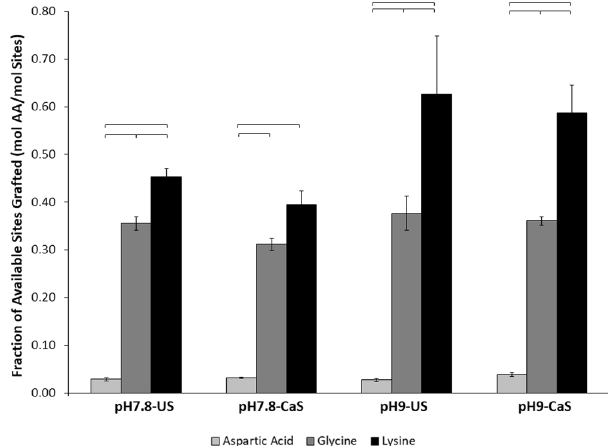
Figure 5. Molar ratio of total sites grafted on the ns-nHA surface using different amino acids (AA) following the ninhydrin protocol. Aspartic acid attached to fewer available graft sites on ns-nHA than glycine or lysine; this is likely indicative of the more balanced layer of aspartic acid on the ns-nHA surface. Data reported as average ± one standard deviation (n = 5). ns-nHA unsaturated with calcium is given as US, while that pre- saturated with calcium is given as CaS. Horizontal bars indicate statistically detectable difference (p < 0.05).